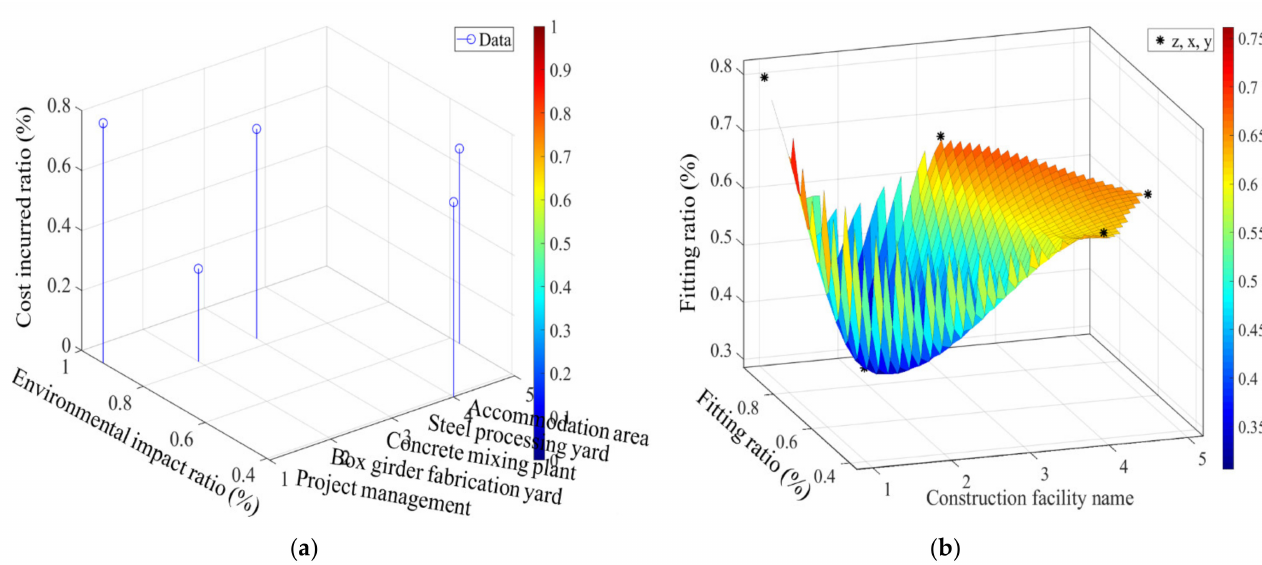
Figure 14. Ancillary facilities: ( a ) The environmental impact and economic cost; ( b ) Interpolation analysis of environmental impact and economic cost.